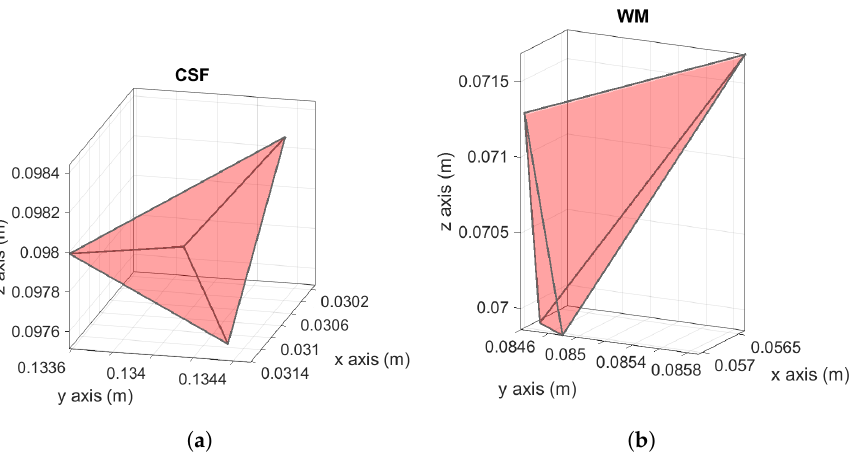
Figure 8. Tetrahedron with q = 0.9 related to the maximum electric field in CSF ( a ). Tetrahedron with q = 0.11 related to the maximum electric field in the white matter ( b